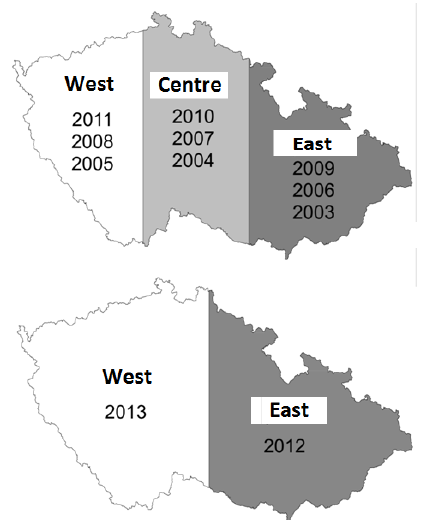
Figure 1: Aerial mapping periods and parts, the Czech Republic